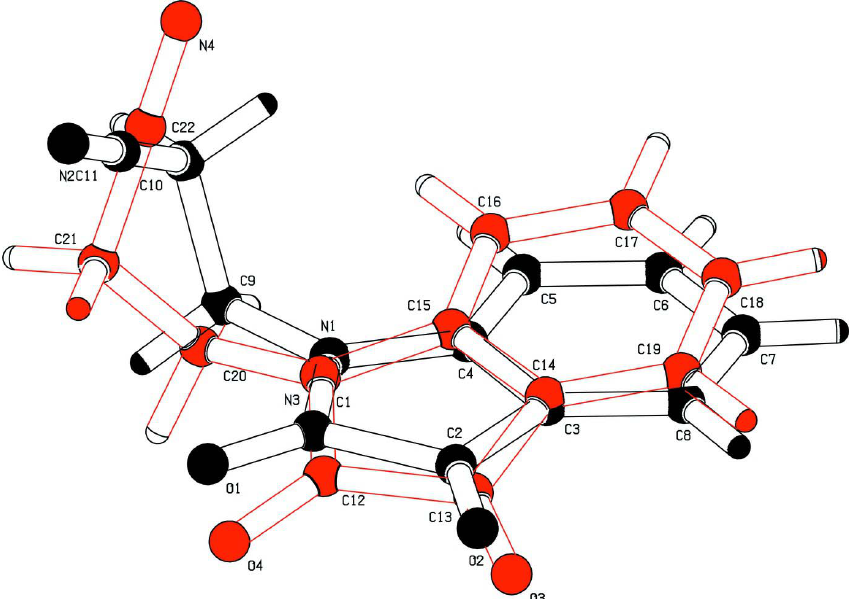
Figure 1 Molecular plot the title compound with the atom-labelling scheme. Displacement ellipsoids are drawn at the 50% probability level.